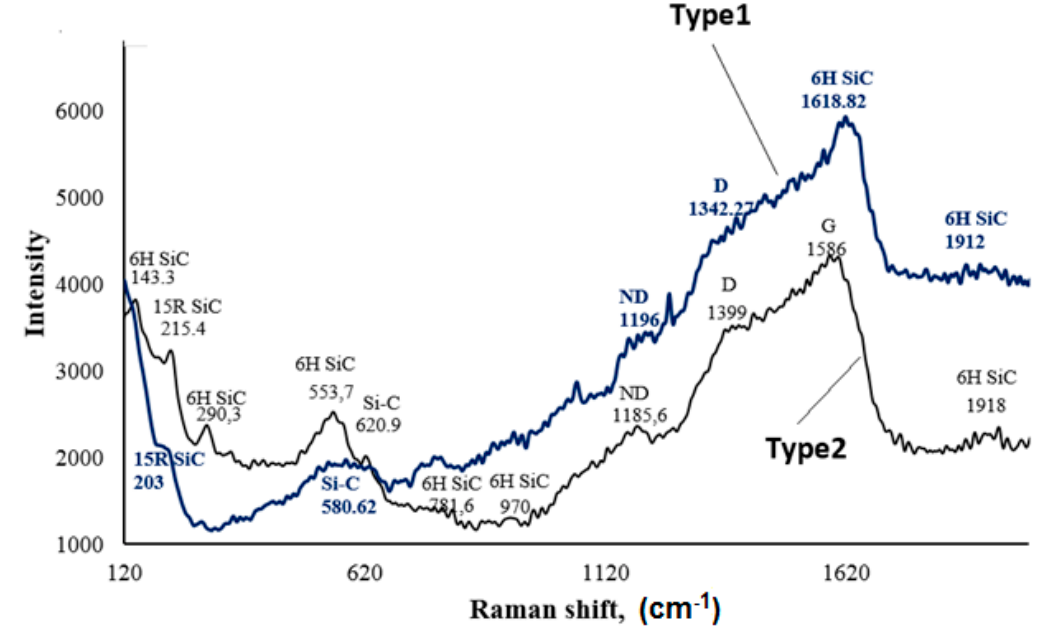
Figure 3. Raman spectra of the pure silicon–carbon films. ND denotes nanocrystalline diamond.